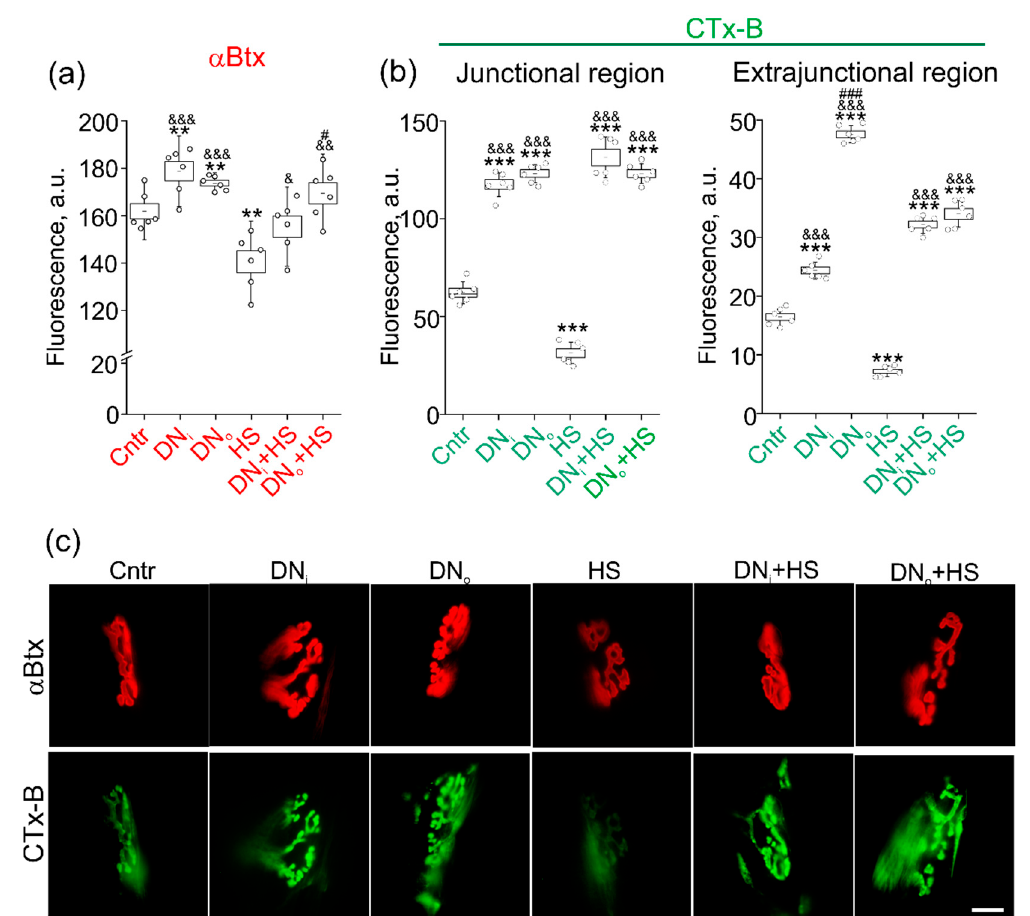
Figure 5. Labeling of AChRs and lipid rafts in muscle. ( a,b ) Quantification of fluorescence (in a.u.) Postsynaptic nAchRs ( a ) or lipid rafts ( b ) were labeled with fluorescent α Btx or CTx-B, respectively, in control (Cntr), suspended muscle (HS), after unilateral denervation in intact (DN i ) and operated (DN o ) muscle, after unilateral denervation following HS in intact (DN i +HS) and operated (DN o +HS) muscle. N = 6 animals for each group. ( b ) Left—in junctional (synaptic) region; right—in extrajunctional region. ** p < 0.01, *** p < 0.001—differences compared control (Cntr); & p < 0.05, && p < 0.01, &&& p < 0.001—differences compared to HS; # p < 0.05, ### p < 0.001—differences between intact and operated limb. p was evaluated by a Mann–Whitney U test. ( c ) Representative fluorescent images of junctional regions. Scale bar—10 µ